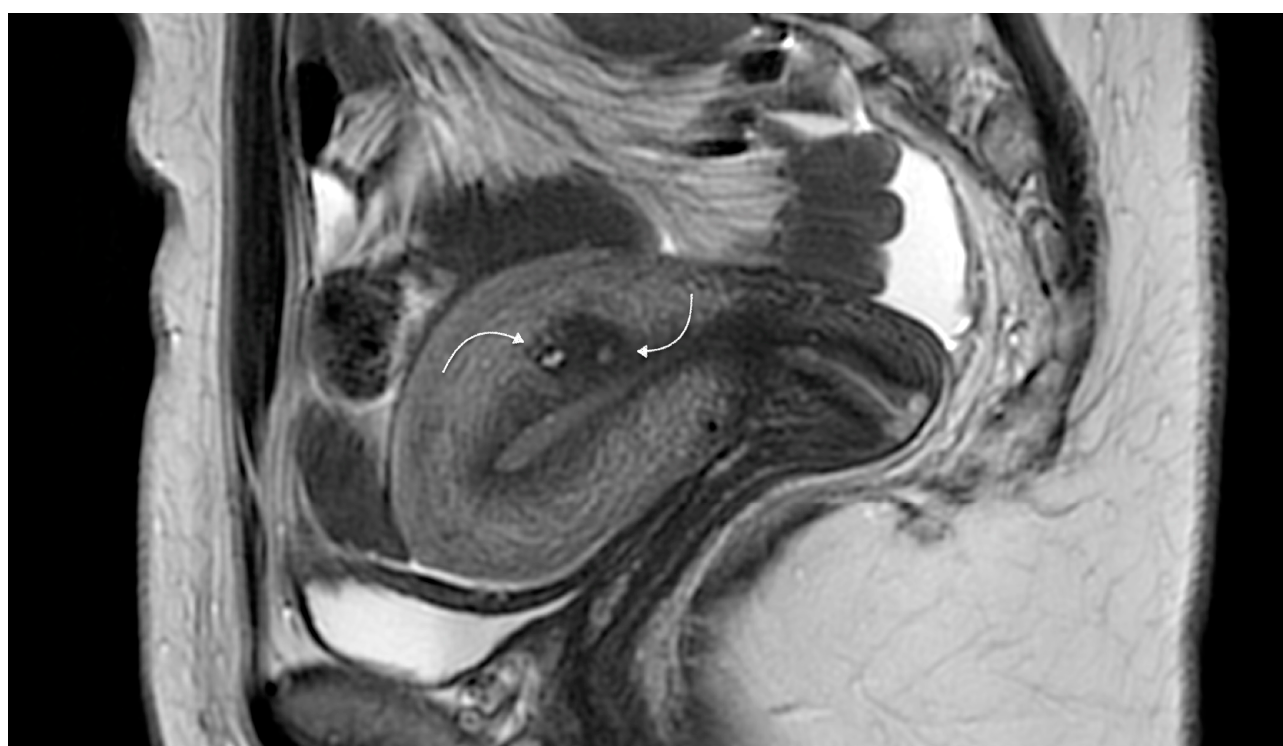
Figure 4. Magnetic resonance imaging showing sagittal two-dimensional T2-weighted magnetic resonance images showing a hypointense lesion containing tiny spots (curved arrows) and located in the posterior wall, adjacent to the endometrial cavity related to focal adenomyosis. Reproduced with permission from Habiba et al. (2020).